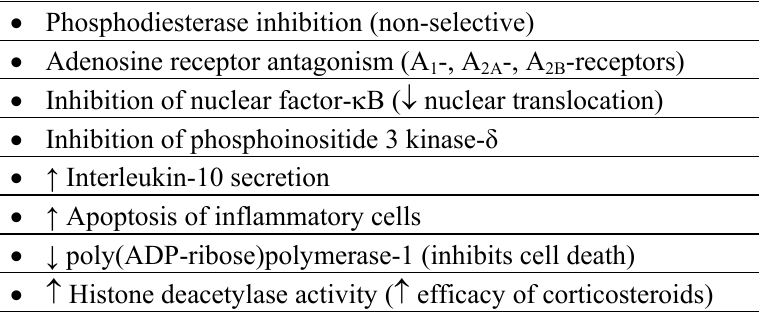
Table 1. Proposed mechanisms of action of